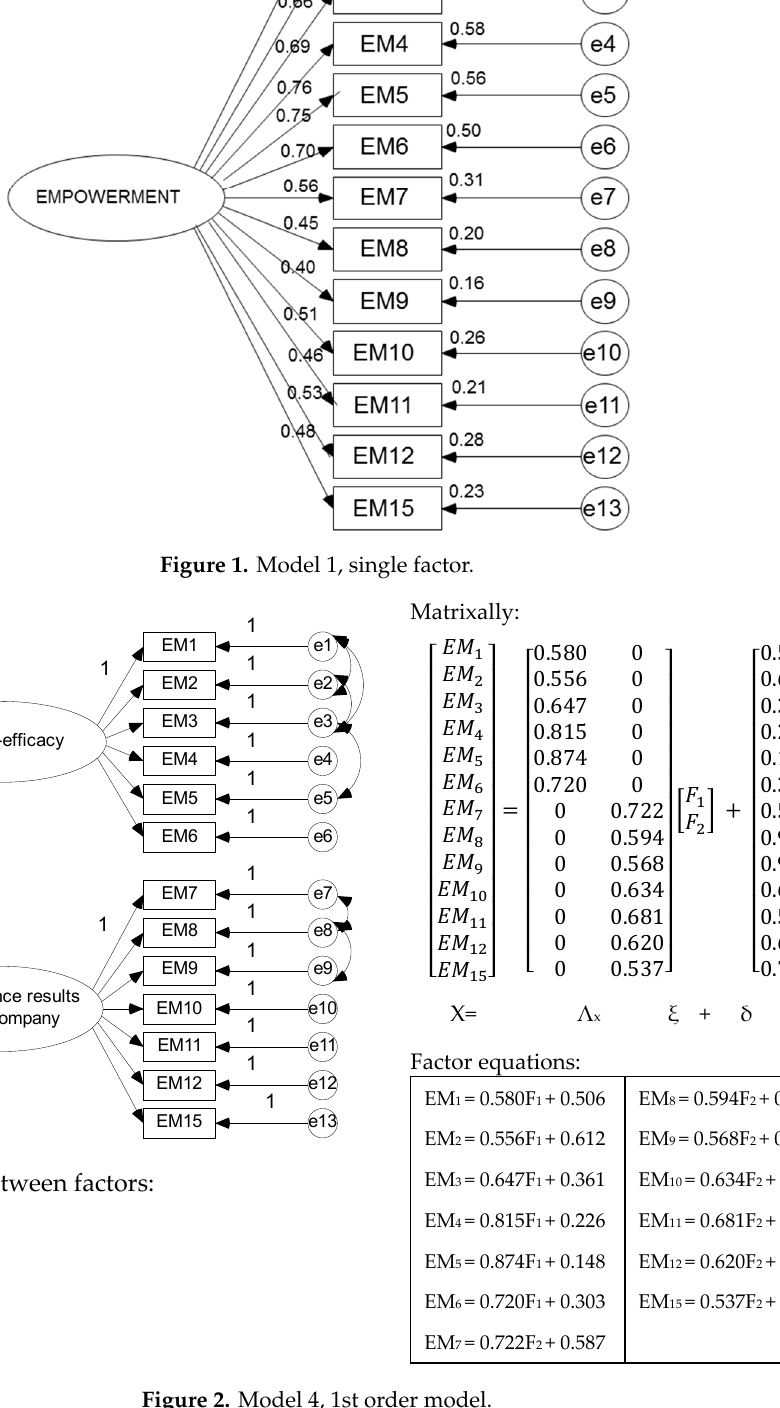
Figure 2. Model 4, 1st order model.